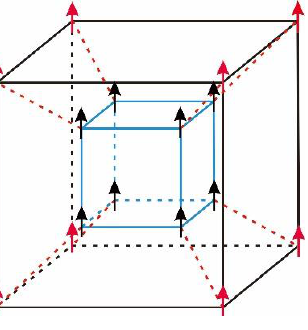
Figure 7. A unit cell of the (3 + 1)D hypercubic Ising lattice in which the spins on the original 3D Ising lattice (black lines) are represented by red arrows and the spins in the high dimensional lattice (blue lines) are represented by black arrows. The red dashed lines connect the vertexes in the two cubes, representing a hypercube in 4D.